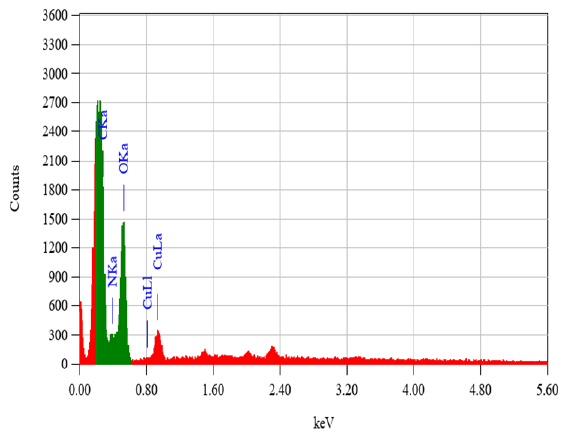
Fig. 8. EDS spectrum CuONPs results